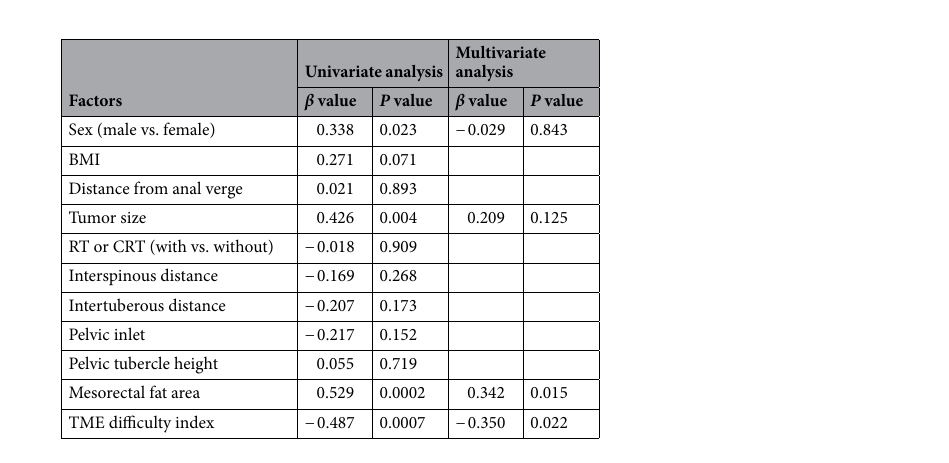
Table 4. Univariate and multivariate regression analyses for operative time for TME in patients who underwent LAR (n = 45). TME total mesorectum excision, LAR low anterior resection, BMI body mass index, RT radiation therapy, CRT